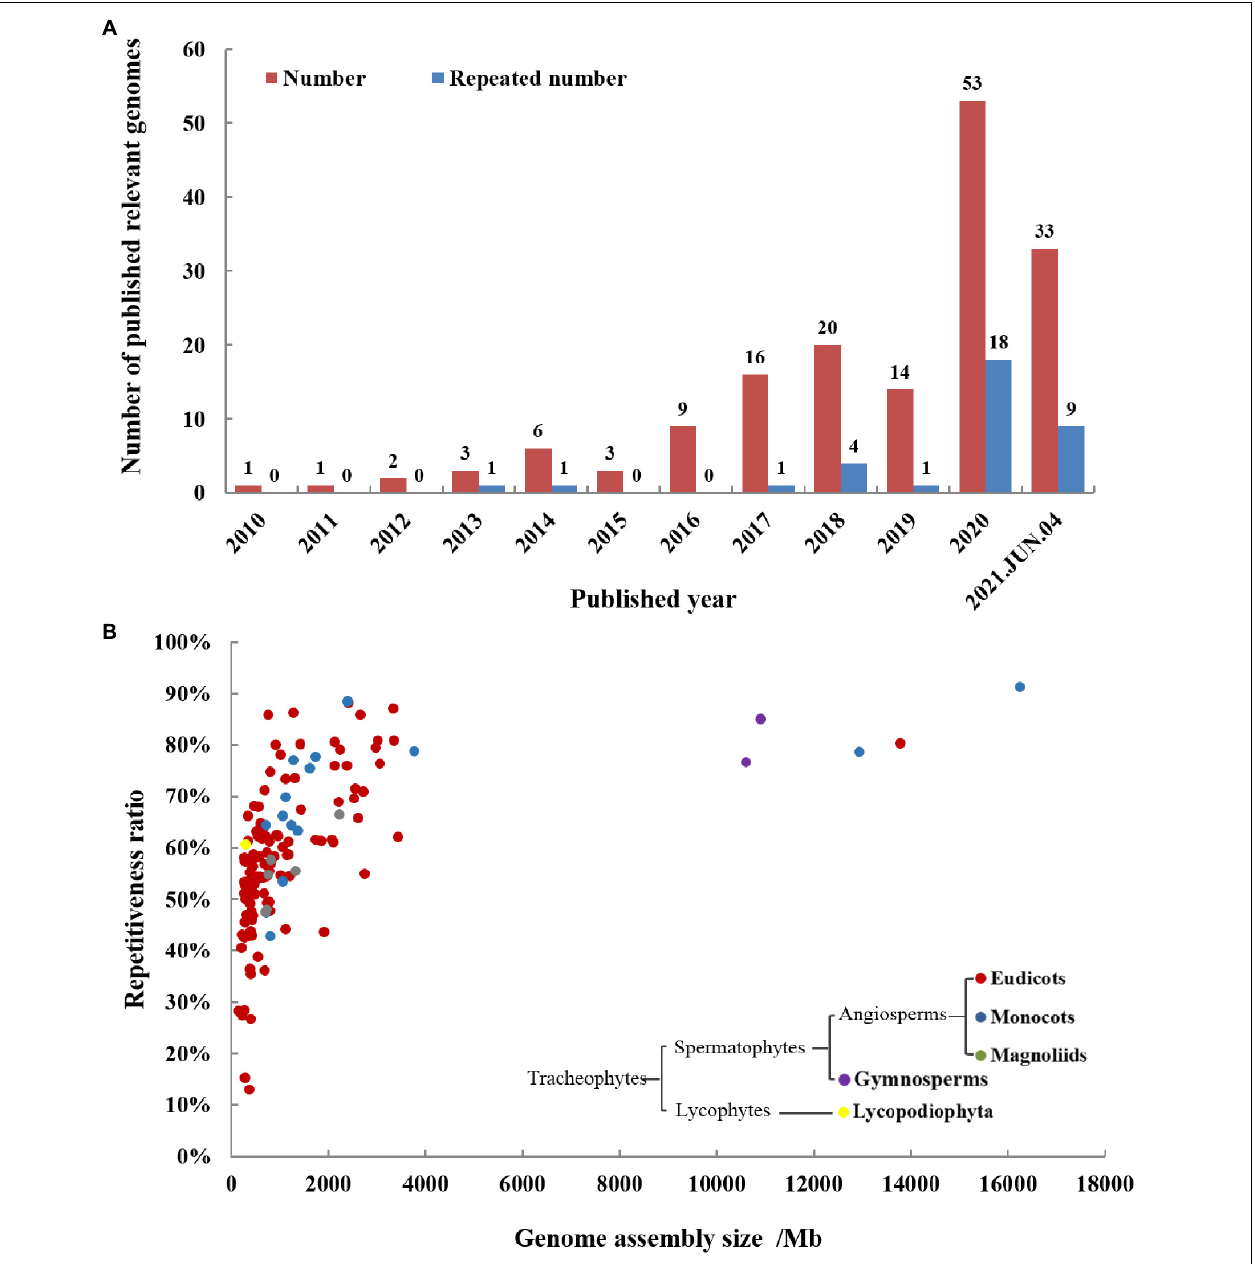
FIGURE 2 | Publication history (A) and general information (B) of medicinal plant genomes. (A) The total number and repeated sequencing number of medicinal plant genomes are increasing year by year, proving that it has received more and more scientific research attention. (B) The figure shows published medicinal genome assemblies analyzed for genome-wide repeat levels and genome size. The repetitiveness of most medicinal plant genomes is generally high and correlated to genome size. The sequenced medicinal plants are divided into five groups based on phylogeny, including lycopodiophyta, gymnosperms, eudicots, monocots, and magnoliids, and eudicot accounts for the majority of